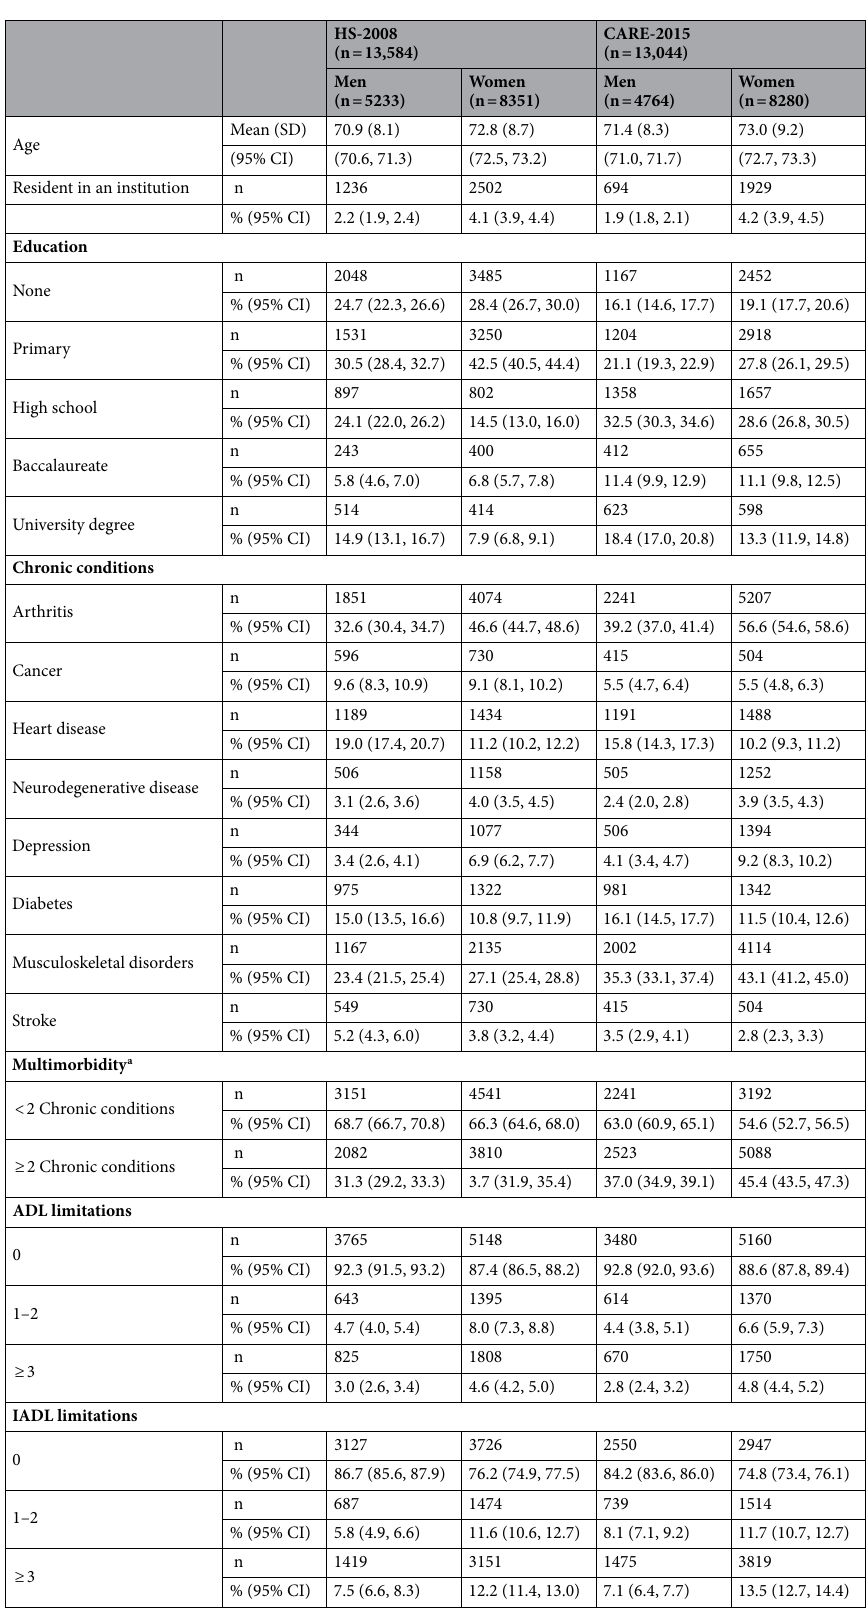
Table 1. Characteristics of participants in the HS-2008 and CARE-2015 surveys. M, mean; SD, standard deviation; HS: Handicap Santé; CARE: Capacities, Aids and REssources; ADL: Activities of Daily Living; IADL: Instrumental Activities of Daily Living. a Using the chronic conditions listed above. Data are n, followed by weighted % and 95% CI, unless stated